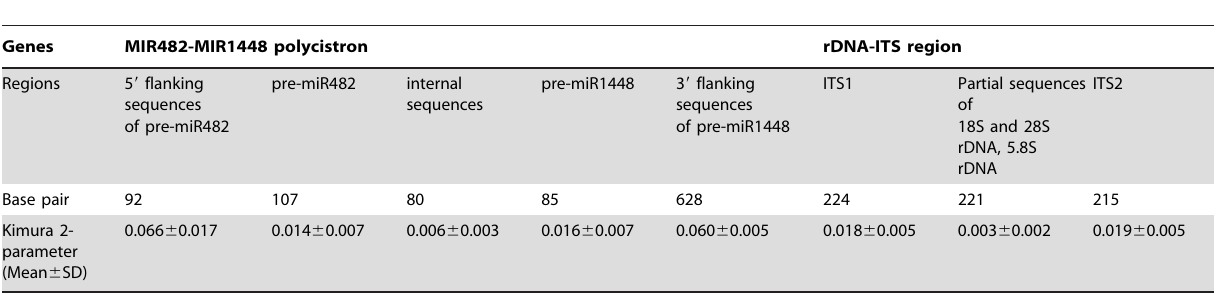
Table 2. The substitution ratio of the MIR482-MIR1448 polycistron and rDNA-ITS regions.